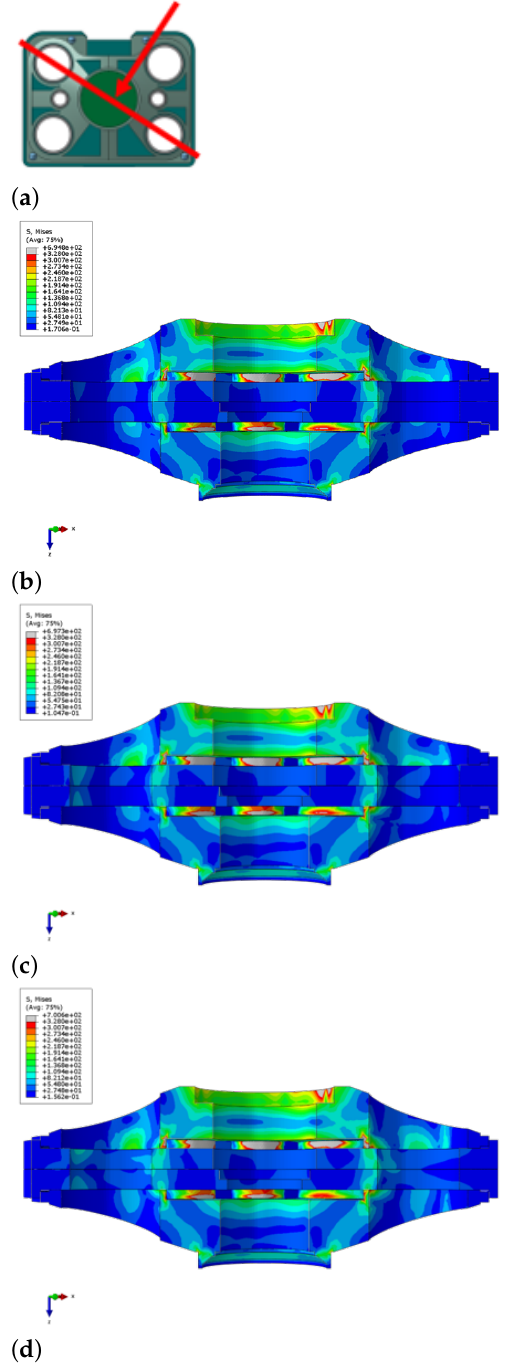
Figure 5. Preliminary finite-element analysis of a compact-flange design. ( a ) Cross-section plane. ( b ) sealing load with 3300 kN applied. ( c ) Coolant pressure 9.6 MPa and 3300 kN sealing load applied. ( d ) All first pipe seals failed. Hydrostatic load surface increased due to